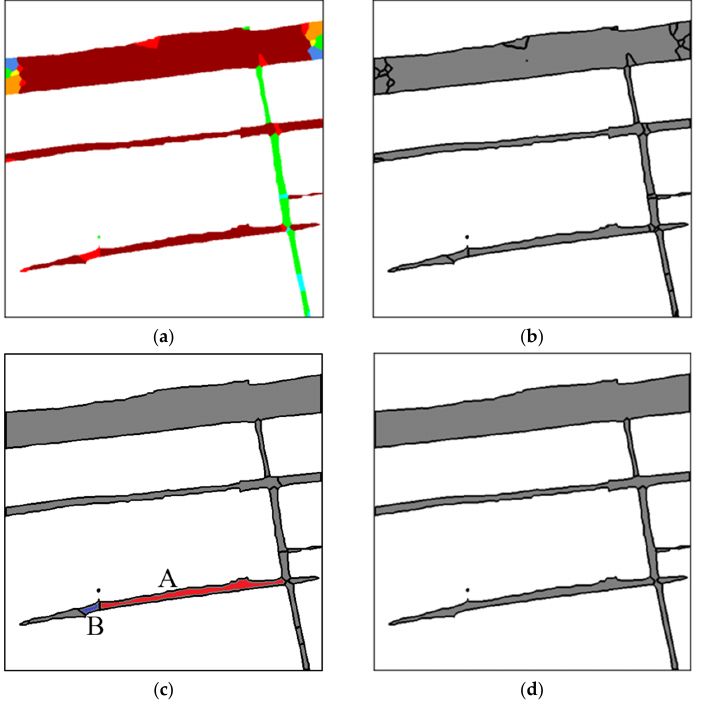
Figure 5. An example for object-based perceptual grouping. ( a ) A detected direction map. ( b ) Direc- tion grouping result obtained from ( a ) different clusters divided by edges, and ( c ) proximity grouping result using ( b ) as an input. Red cluster A and blue cluster B are two adjacent clusters that satisfy continuity rules. ( d ) Continuity grouping result using ( c ) as an input.